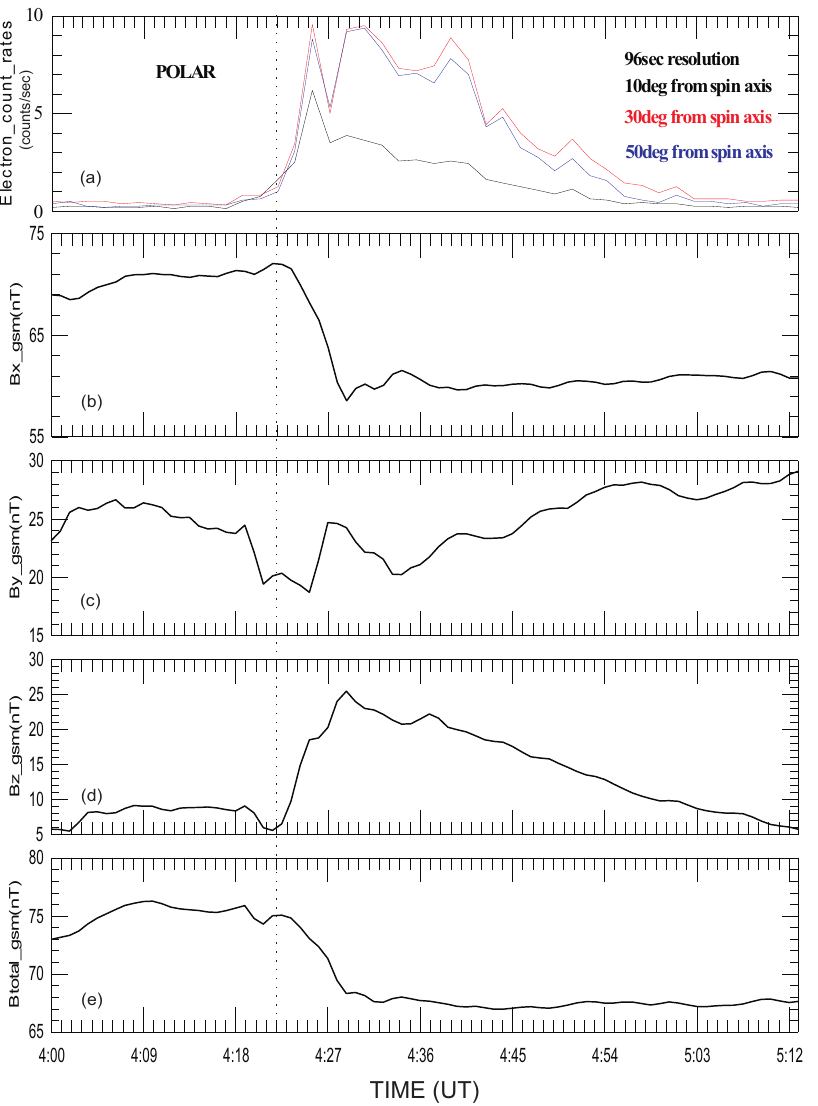
Fig. 5. Electron count rates in three different look directions relative to the Polar spin axis. Also shown are magnetic field components, together with the field magnitude in GSM coordinates. Note the prominent field dipolarization at ∼ 04:22 UT which coincides with the electron